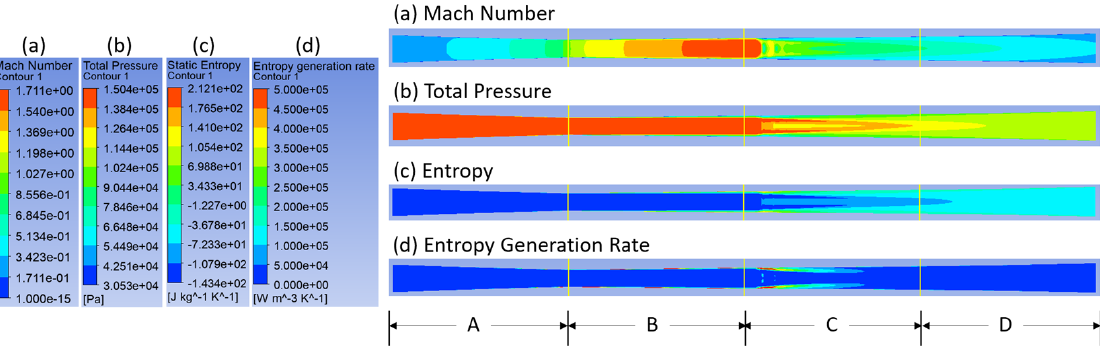
Figure 4. Distribution of Mach number, total pressure, entropy, and EGR within sections of the Laval nozzle.